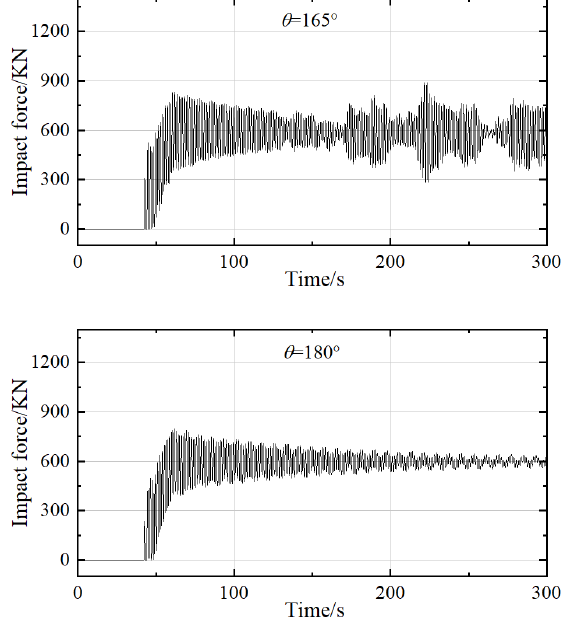
Figure 11. The impact force of the offshore crane vessel under different wave directions.